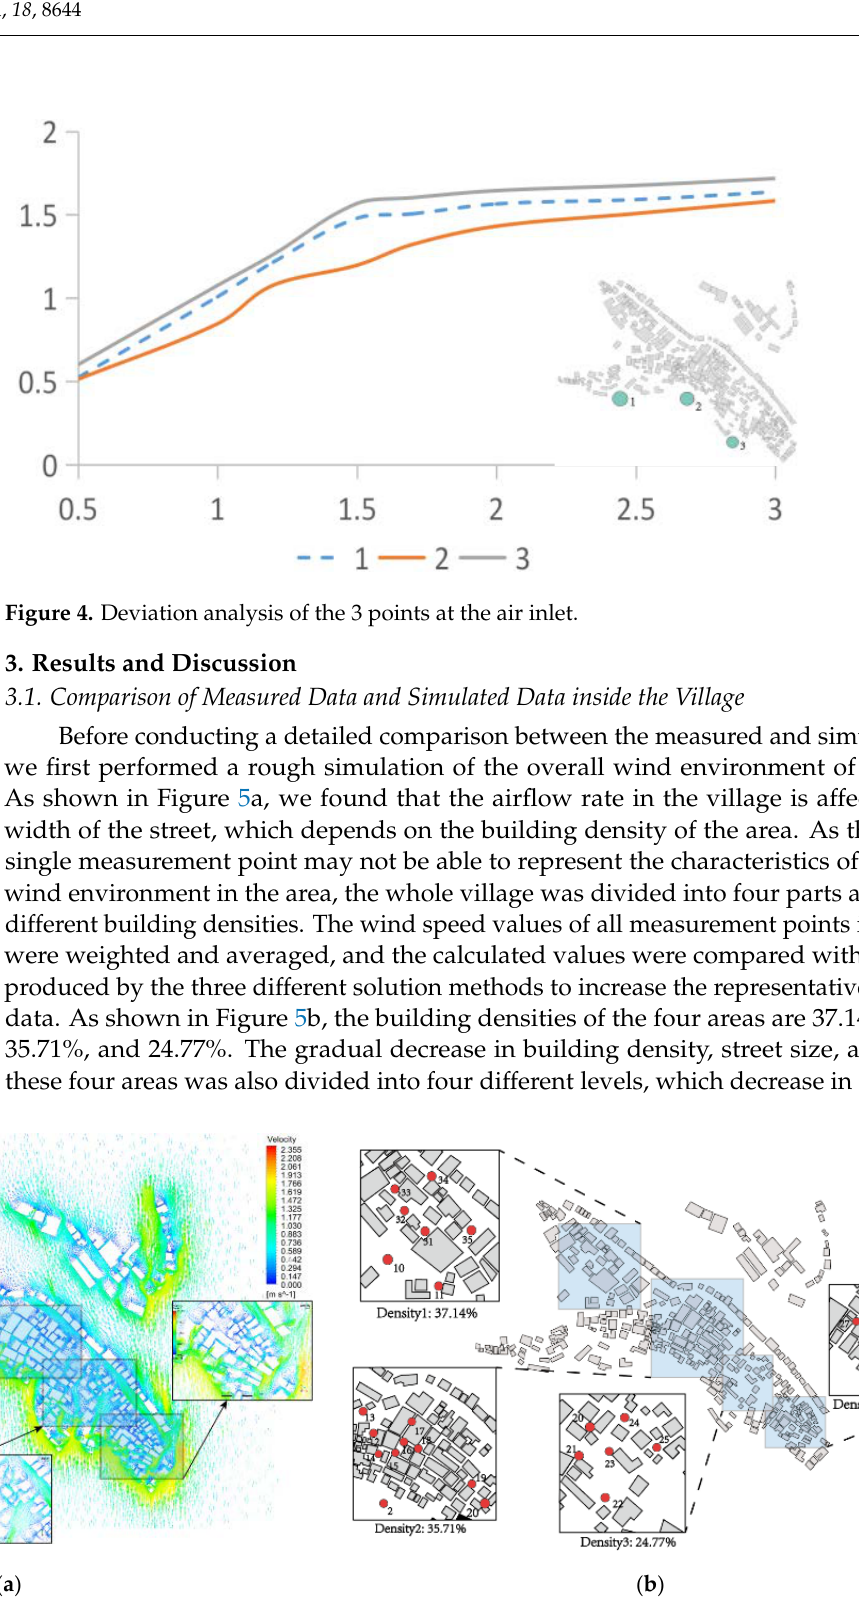
( e ) Figure 3 . ( a ) Distribution of measuring points. ( b ) Scope of the study case. ( c ) Outdoor temperature distribution of study cases throughout the year. ( d ) Study case boundary conditions. ( e ) Meshing of study cases. 2.3. Setting and Verification of the Air Inlet Wind Speed The wind speed of the air inlet required for the simulation was determined using the measured data. As shown in Figure 3a, the average wind speed of the three green points was taken as the wind speed of the air inlet during the simulation. Before this, it was necessary to compare the wind speed at the three green points. If the wind speed differ- ence between the three points was too large, it could not be used as the basis for the wind